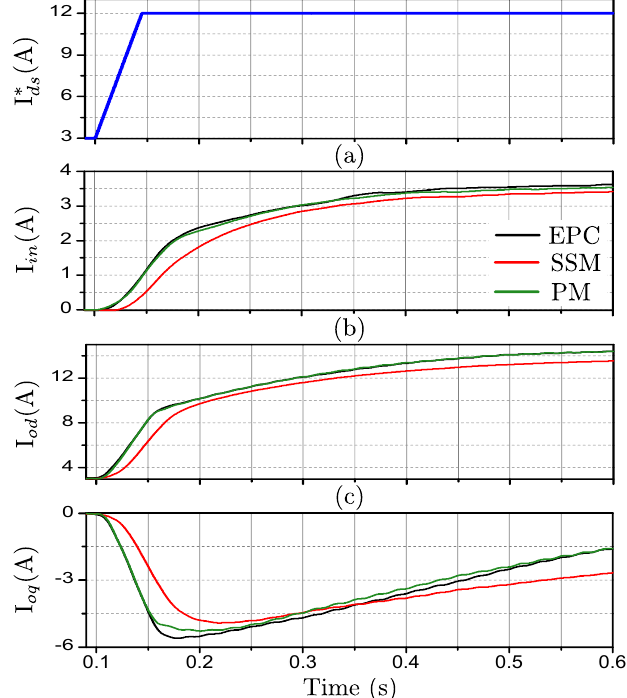
Figure 13. Comparison between ( a ) I in , ( b ) I od and ( c ) I oq of the EPC and the small-signal (SSM) and polytopic models (PM) for a step in I ∗